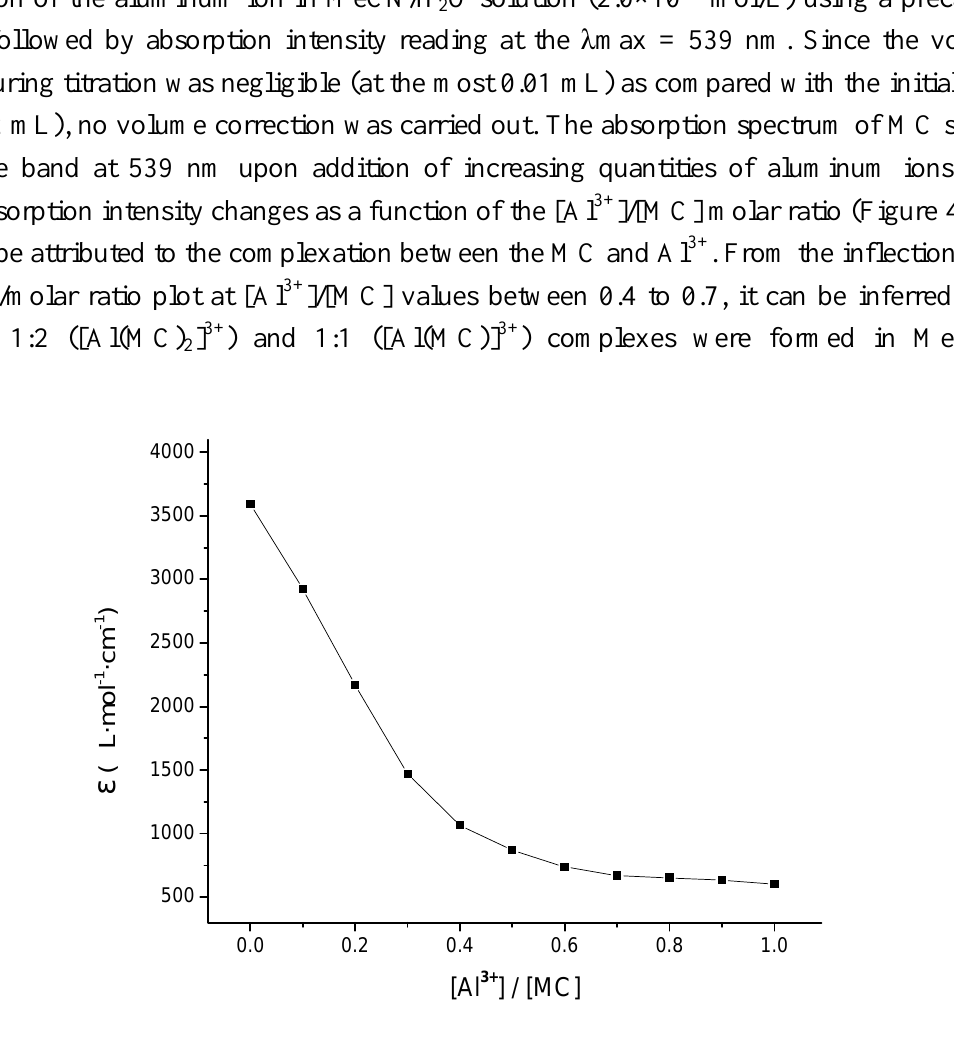
Figure 4. Absorption intensity / mole ratio data of spiropyran (1×10  5 mol/L, 298 K, MeCN/H 6:4, V/V) after irradiation for 10 min at 365 nm light with titration of Al 3+ at different